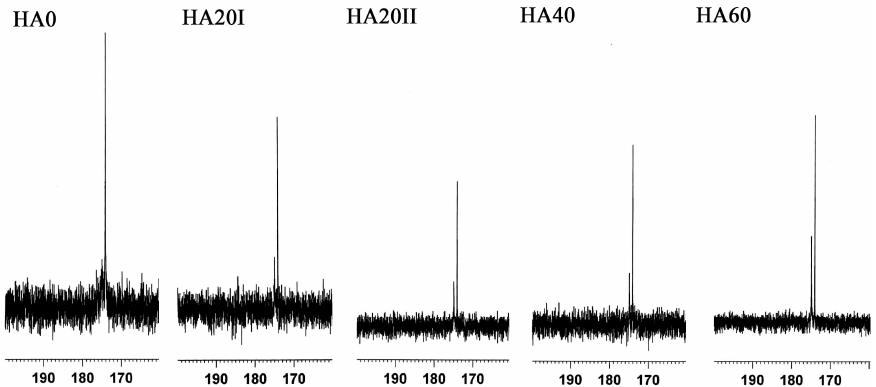
Figure 1. 13 C NMR spectra of γ -ray treated and untreated hyaluronic acid (HA) samples at chemical shifts between 160 and 190 ppm.